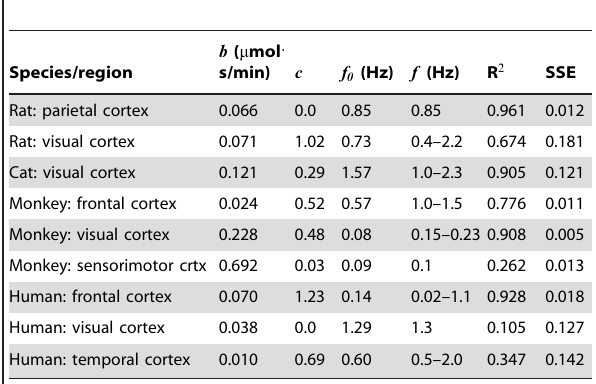
Species/region correlation significance